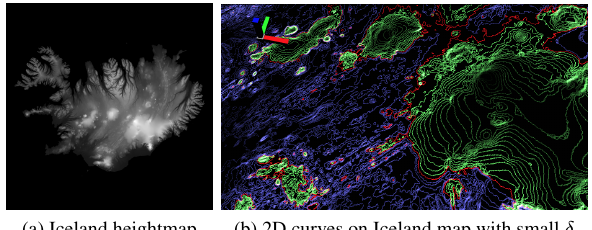
Figure 11. Input test heightmap of Iceland (a) and close-up view of resulting 2D curves visualization (b).